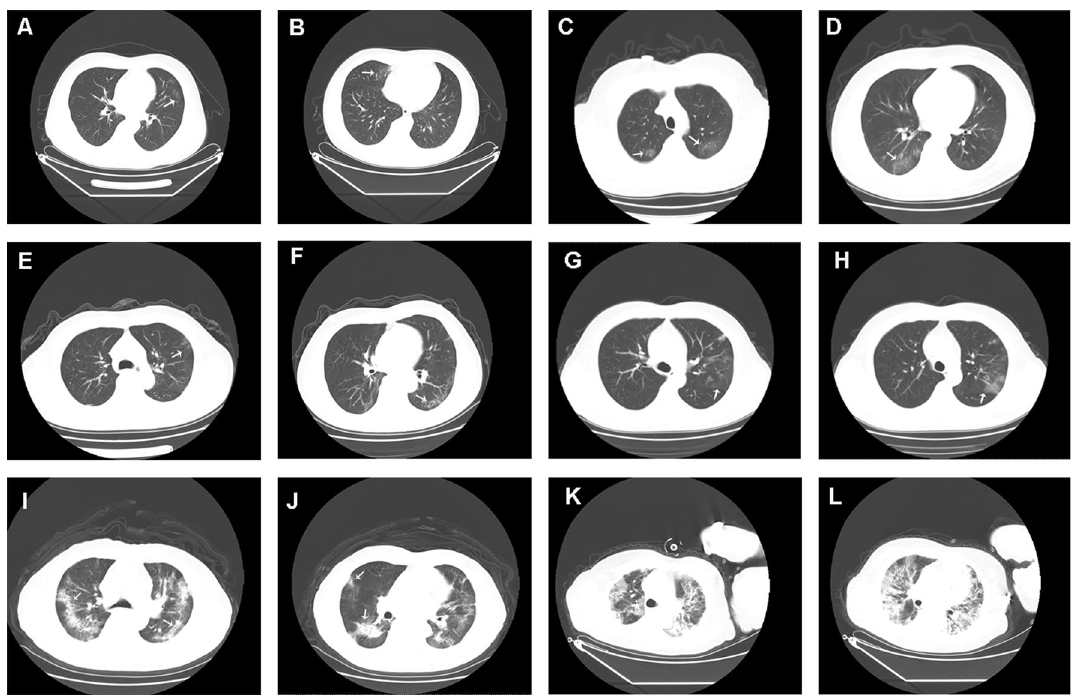
Figure 2. Chest CT images of the patients with COVID-19. ( A , B ) Images of a 38-year-old patient (Non- aggravation group) with few flocculent/patchy compact shadows in right lower lobe and left middle lobe. ( C , D ) Images of a 32-year-old patient (Non-aggravation group) with GGO in right middle/lower lobe and left middle lobe. ( E , F ) Images of a 58-year-old patient with multiple GGO, and patchy compact shadows at the periphery of the lung. ( G , H ) Images of a 69-year-old patient (Non-aggravation group) with GGO predominantly peripheral distribution in both lungs. ( I , J ) Images of an 89-year-old patient (Aggravation group) with diffuse, plaque- like, ground-glass opacities in both lungs centrally and peripherally. ( K , L ) Images of a 70-year-old patient (Aggravation group) with multiple typical GGO and multifocal consolidation shadows in bilateral